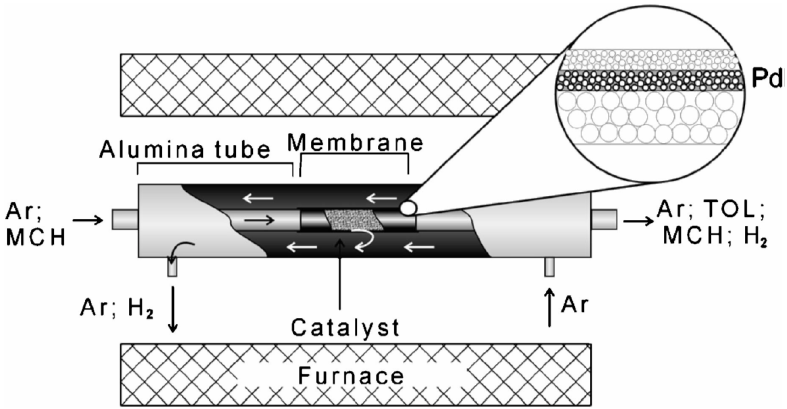
Figure 14. Schematic representation of a pore-filled type membrane integrated in a packed-bed membrane reactor for the dehydrogenation of methylcyclohexane into toluene and hydrogen. Reprinted from [213] with permission from The Chemical Society of Japan.